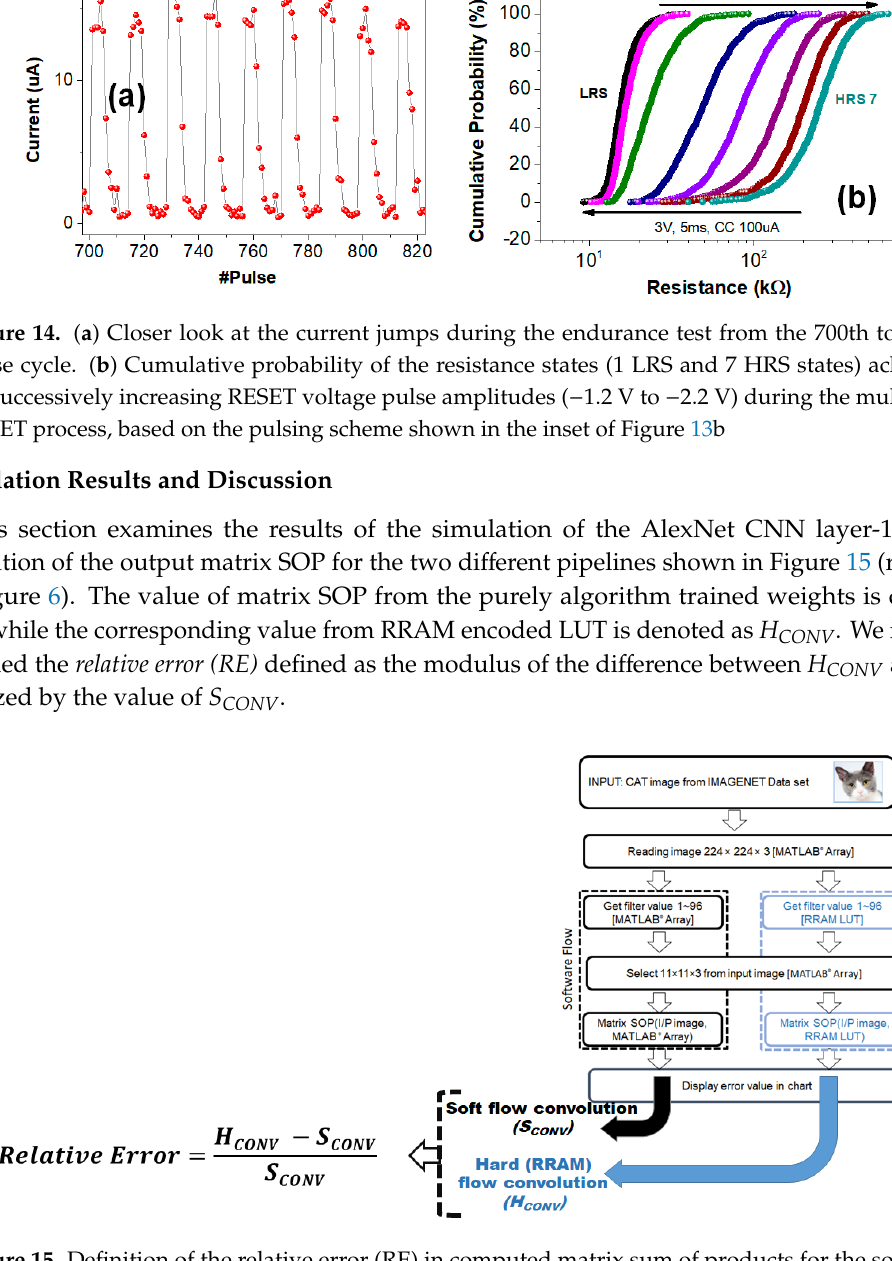
Figure 16. Bitwise relative error for all the 7-HRS values listed for different 4-bit positions along the 32-bit binary representation of the floating-point value for the CNN weights. The error values are listed separately for the red, green and blue colors accordingly . 6. Conclusions This study presented a comprehensive methodology of assessing the impact of variability in the RRAM resistance distributions for the low and high resistance states on the image classification error